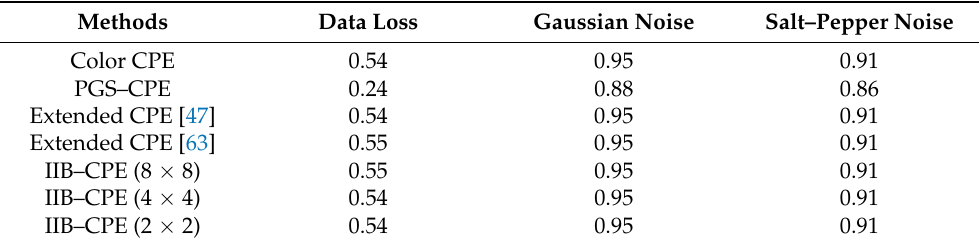
Table 9. Quality of the recovered images under the different types of loss attacks shown in Figures 21 and